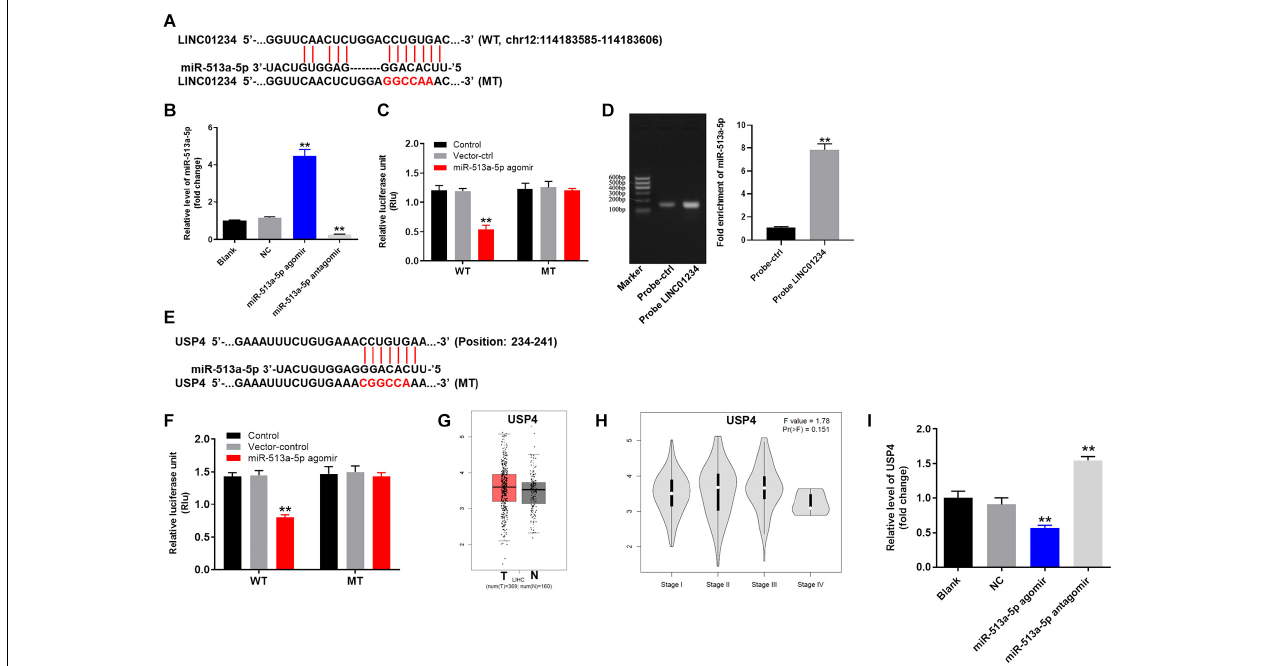
FIGURE 3 | LINC01234 sponged miR-513a-5p. (A) Gene structure of LINC01234 indicating the predicted miR-513a-5p binding site in its 3 (cid:48) UTR. (B) Huh-7 cells were transfected with miR-513a-5p agomir/antagomir for 24 h. Then, cell transfection was verified by qRT-PCR. (C) The luciferase activity in Huh-7 cells after co-transfecting a plasmid encoding the wild-type (WT) or mutant (MT) LINC01234 3 (cid:48) -UTR and miR-513a-5p. (D) Co-localization of LINC01234 and miR-513a-5p detected using RNA pull-down. (E) Gene structure of USP4 indicating the predicted miR-513a-5p binding site in its 3 (cid:48) UTR. (F) The luciferase activity in Huh-7 cells after co-transfecting a plasmid encoding the wild-type (WT) or mutant (MT) USP4 3 (cid:48) -UTR and miR-513a-5p. (G) The differential expression of USP4 in normal and tumor tissues was analyzed from the data of TCGA. (H) The correlation between USP4 and different stages of liver cancer was analyzed. (I) The expression of USP4 in liver cancer cells was measured by qRT-PCR. ** P < 0.01 compared to